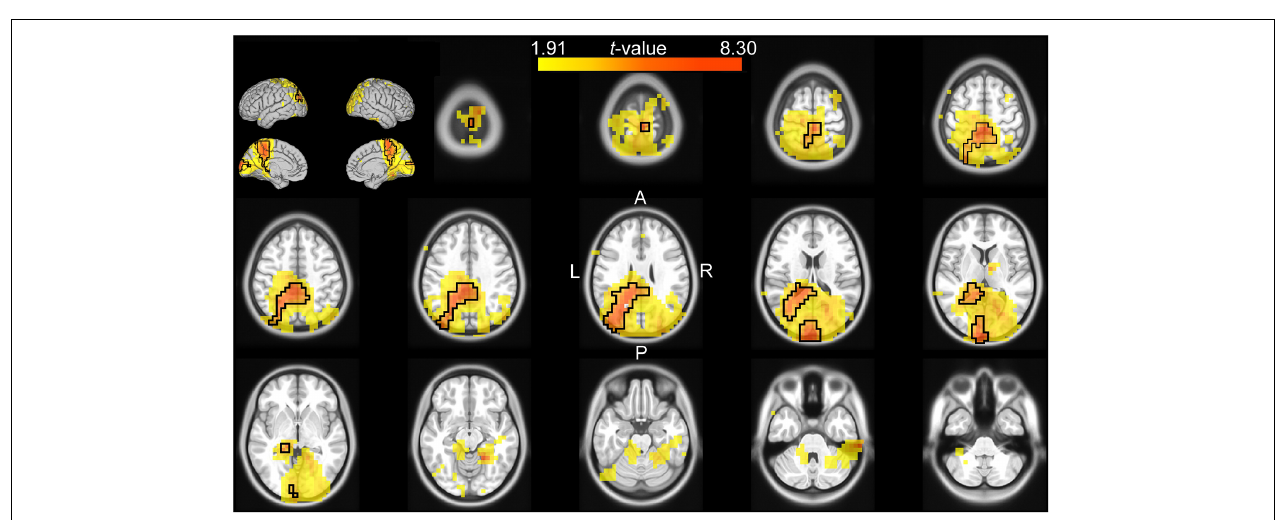
FIGURE 4 | Source analysis of the difference in theta power between valid and invalid cue trials during the reaction time (0–0.4 s after target onset). The t -values of the difference are mapped onto the transverse slices and surface of the MNI standard brain. The color scale represents positive t -values from the 75th to 100th percentile of the absolute t -value distribution. The cluster-based selected area is surrounded by a black